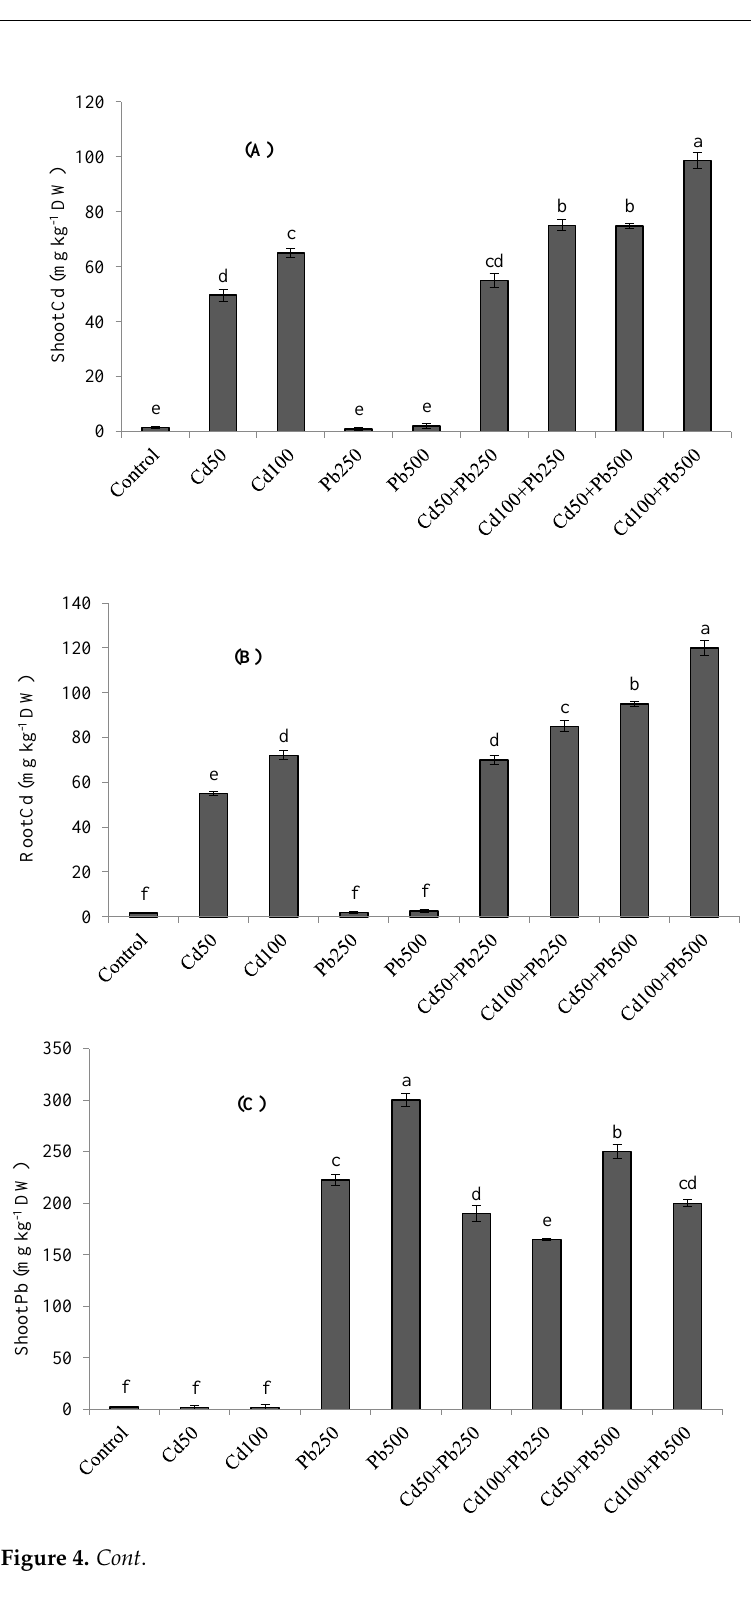
Figure 4. Effect of different levels of Cd, Pb and their combinations on Cd concentration in shoot ( A ), root ( B ) and Pb concentration in shoot ( C ) and root ( D ) of quinoa. Different letters represent the significant difference among the treatments at a 5% significance level. Table 3. Bioconcentration factor (BCF), translocation factor (TF) and tolerance index (TI) of quinoa plants exposed to various concentrations of cadmium and lead under hydroponic conditions. Cd Pb Treatments (µM)